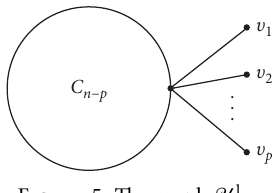
Figure 5: The graph U 1